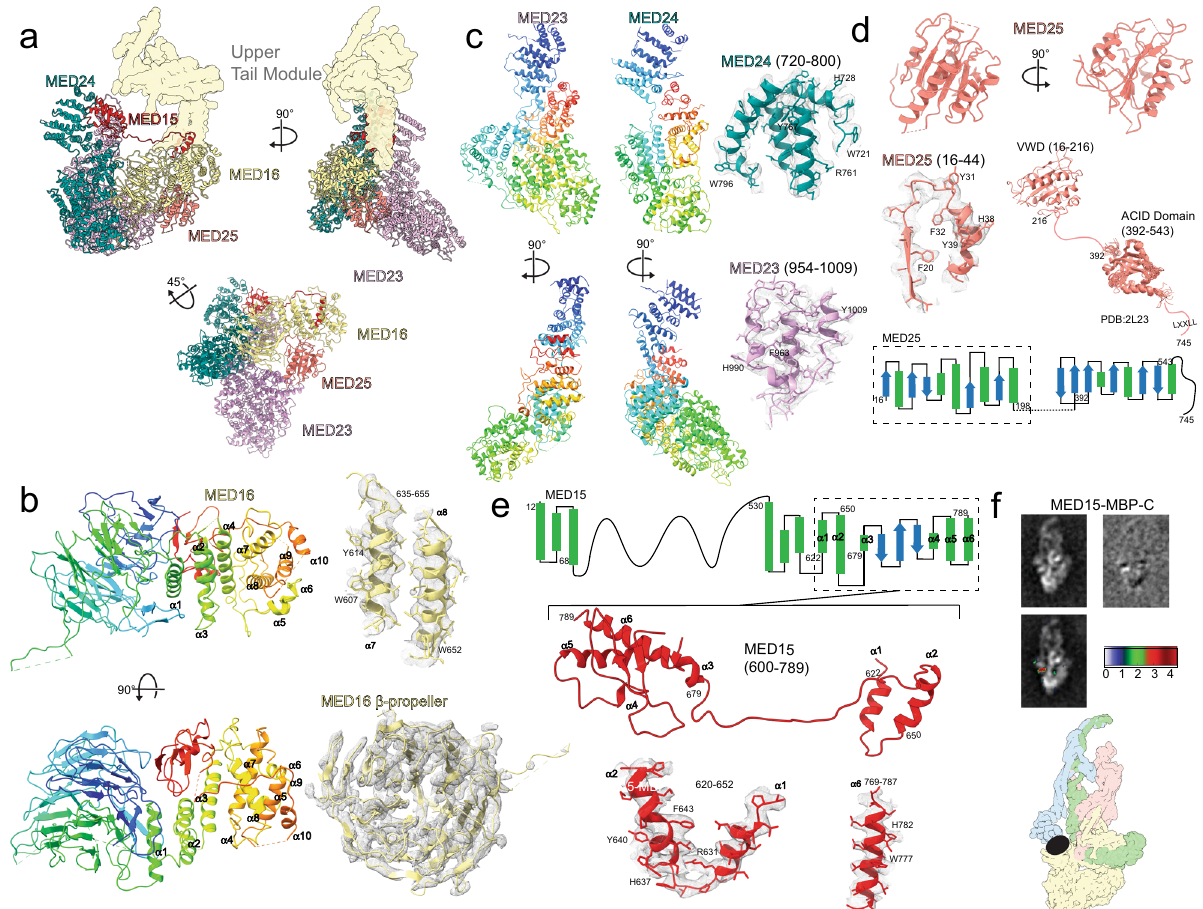
Fig. 5 Structure of the mammalian lower Tail. a Overall lower Tail structure (upper Tail in light yellow). b MED16 structure with β -propeller N-terminal and α -helical C-terminal domains colored from blue to red (top left) and map-to-model comparisons (top right), and details of the N-terminal β -propeller domain (bottom). c Models for MED23 and MED24 (left) show remarkable similarity in overall organization of the subunits (subunit color changes from blue (N-terminus) to red (C-terminus)) and correspondence between the models and the cryo-EM map (right). d Structure of the N-terminal von